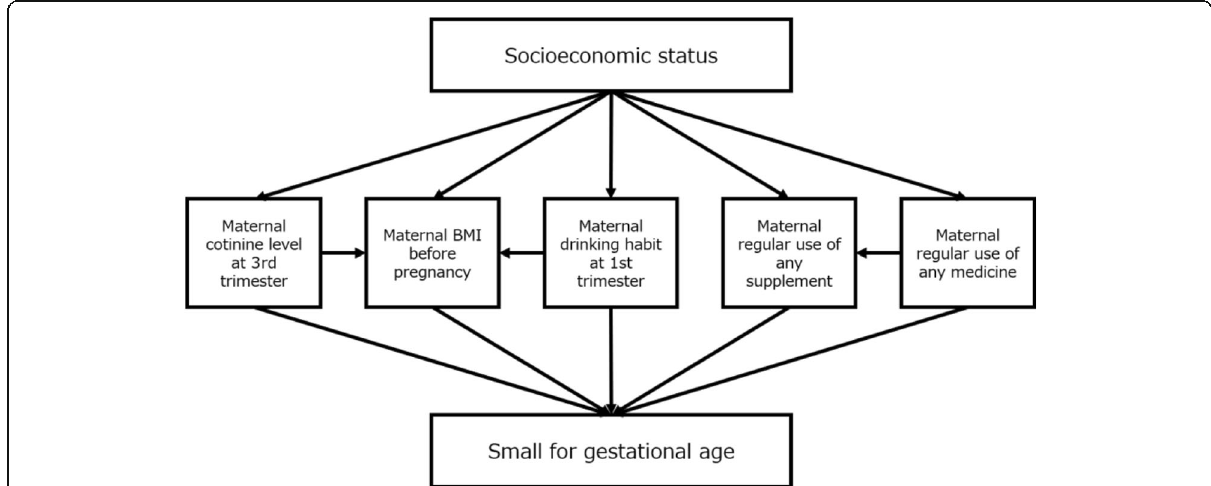
Fig. 1 Directed acyclic graph for the mediating factors between parental SES and small for gestational